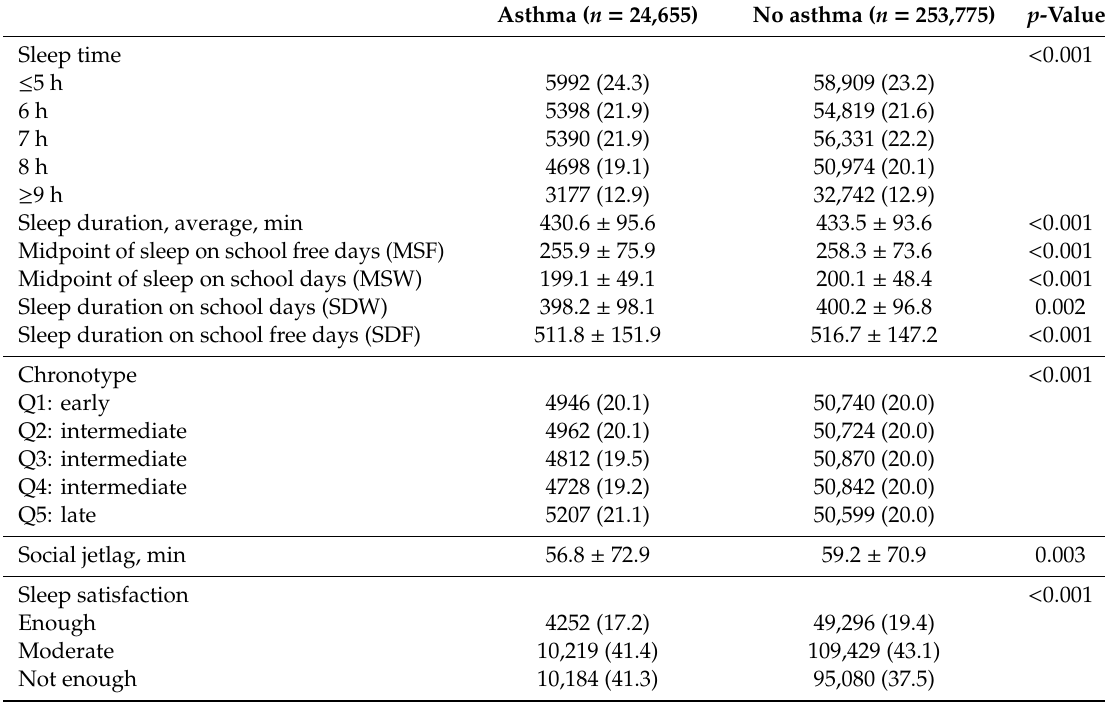
Table 2. Sleep variables in asthma and non-asthma adolescents.